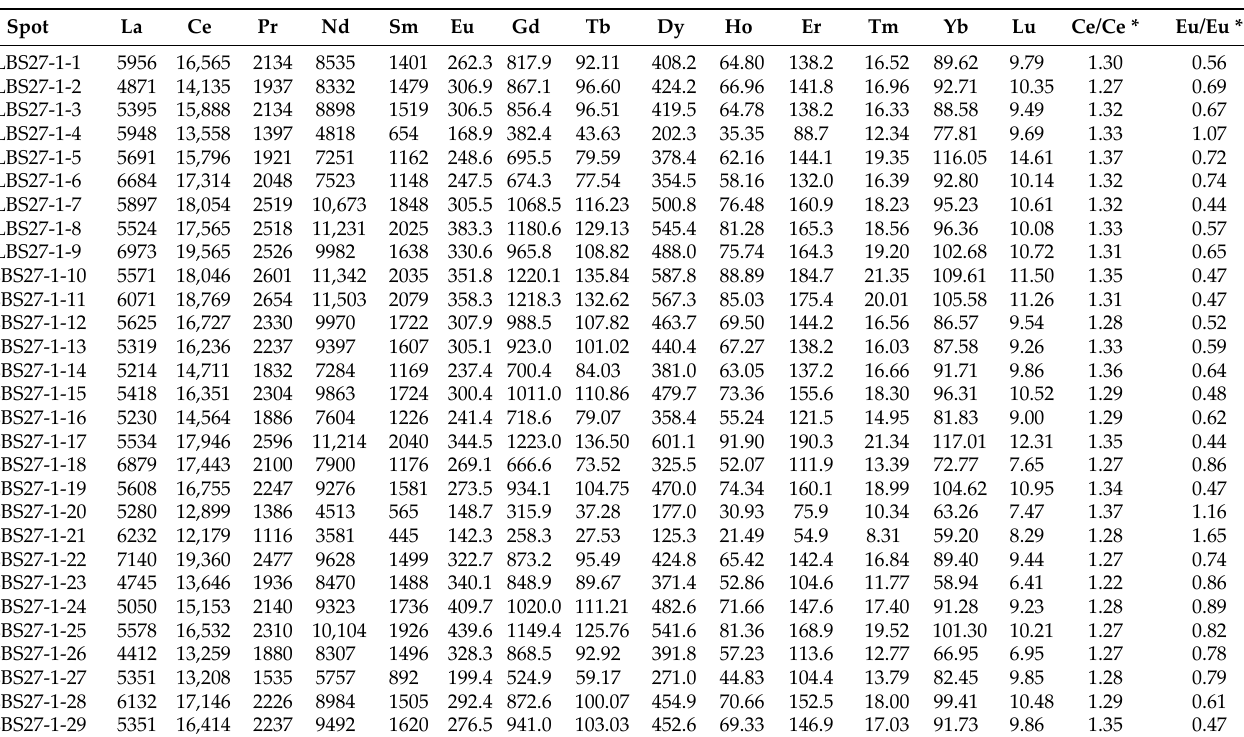
Table 2. REE compositions for the sphene in the alkaline complex of the Longbaoshan area (ppm). Ce * ： theoretical Ce value, Eu * ： theoretical Eu